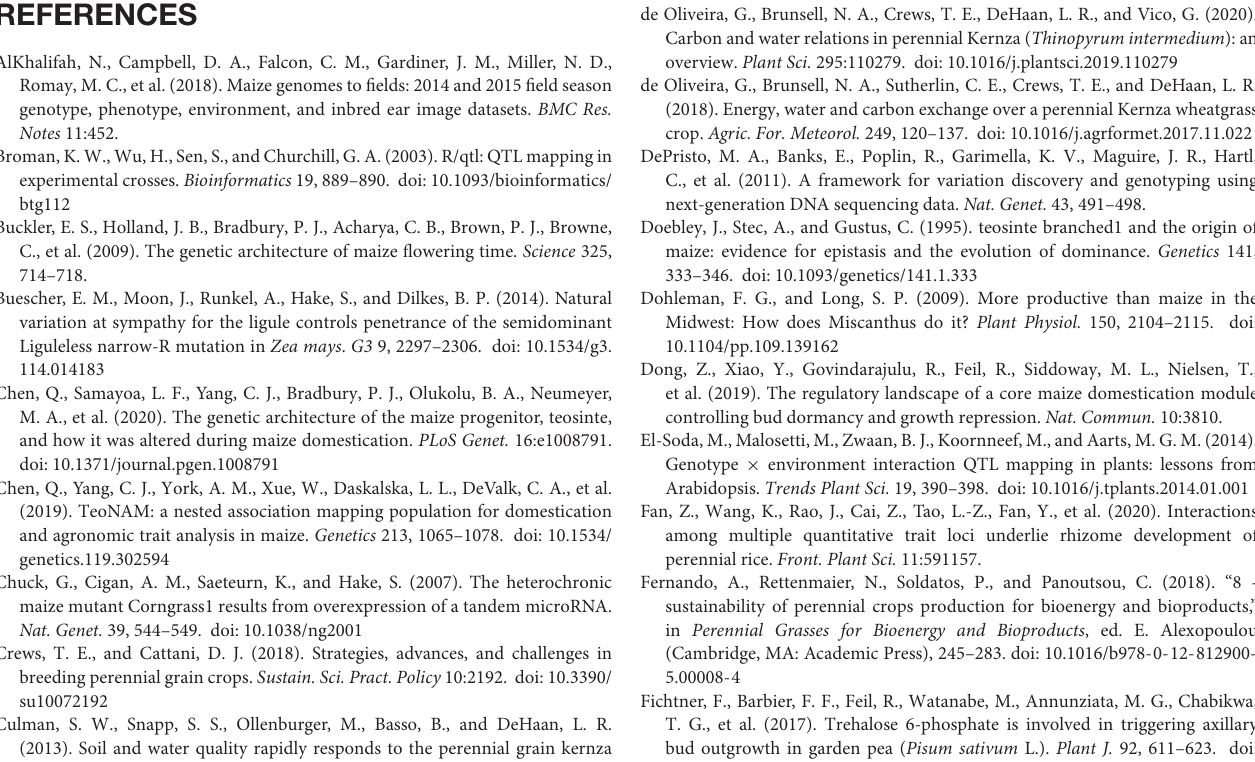
Supplementary Figure 1 | Distribution of filtered homozygous “Gigi” SNPs mapped to P39v1 reference assembly.